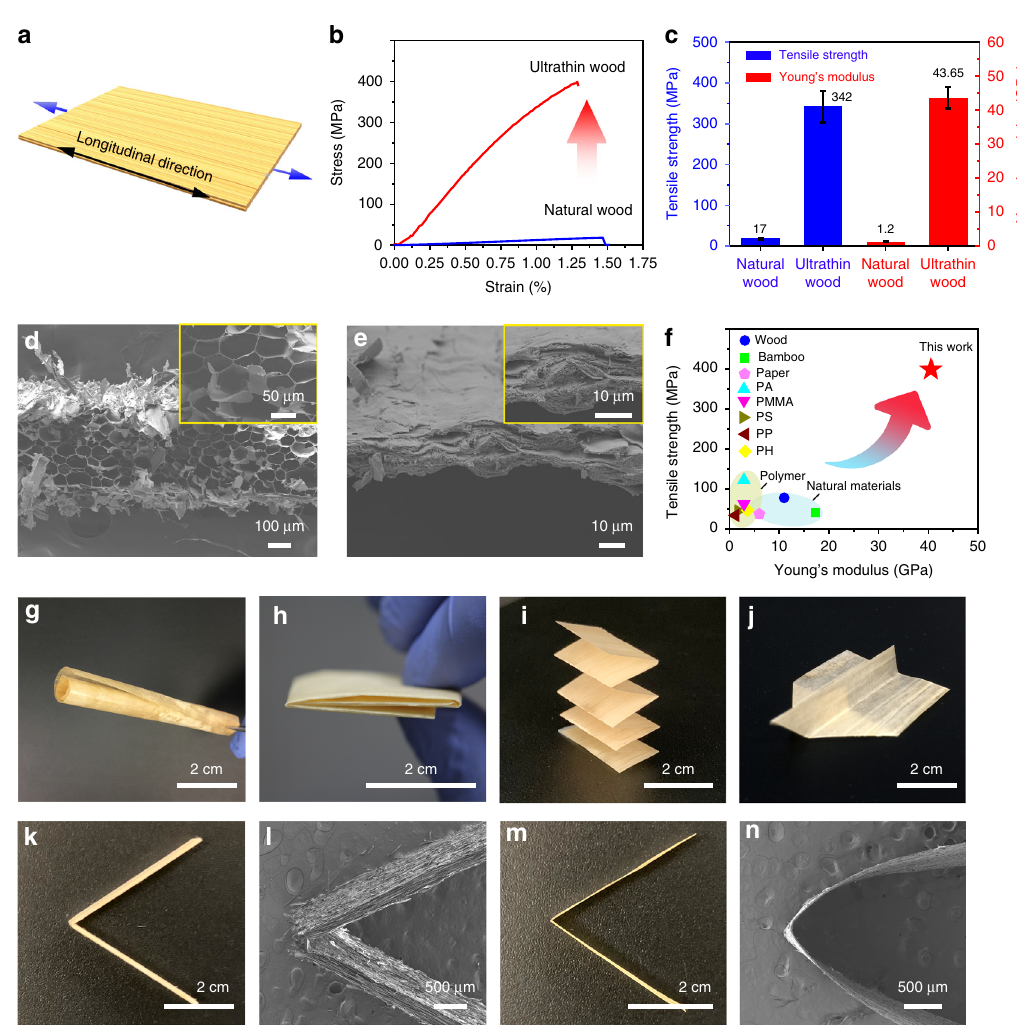
Fig. 3 Mechanical properties of wood fi lms. a Schematic of the tensile test along the longitudinal direction. b Corresponding tensile stress as a function of strain for the natural wood (blue line) and ultrathin wood fi lm (red line). c Comparison of the tensile strength and Young ’ s modulus of the natural wood and ultrathin wood fi lm. Error bars represent standard deviation. d, e SEM images of the tensile fracture surface of the natural wood and ultrathin wood fi lm. f Comparison of the tensile strength and Young ’ s modulus of the ultrathin wood fi lm with other widely used polymer and natural materials 50 . (PA: Polyamide; PMMA: Poly (methyl methacrylate); PS: Polystyrene; PP: Polypropylene) g – j Photographs of the ultrathin wood fi lm demonstrating its fl exibility and various origami designs. k , l Photograph and SEM image of the natural wood after bending, showing its rigid wood structure. m , n Photograph and SEM image of the ultrathin wood fi lm after bending, showing its excellent fl exibility and